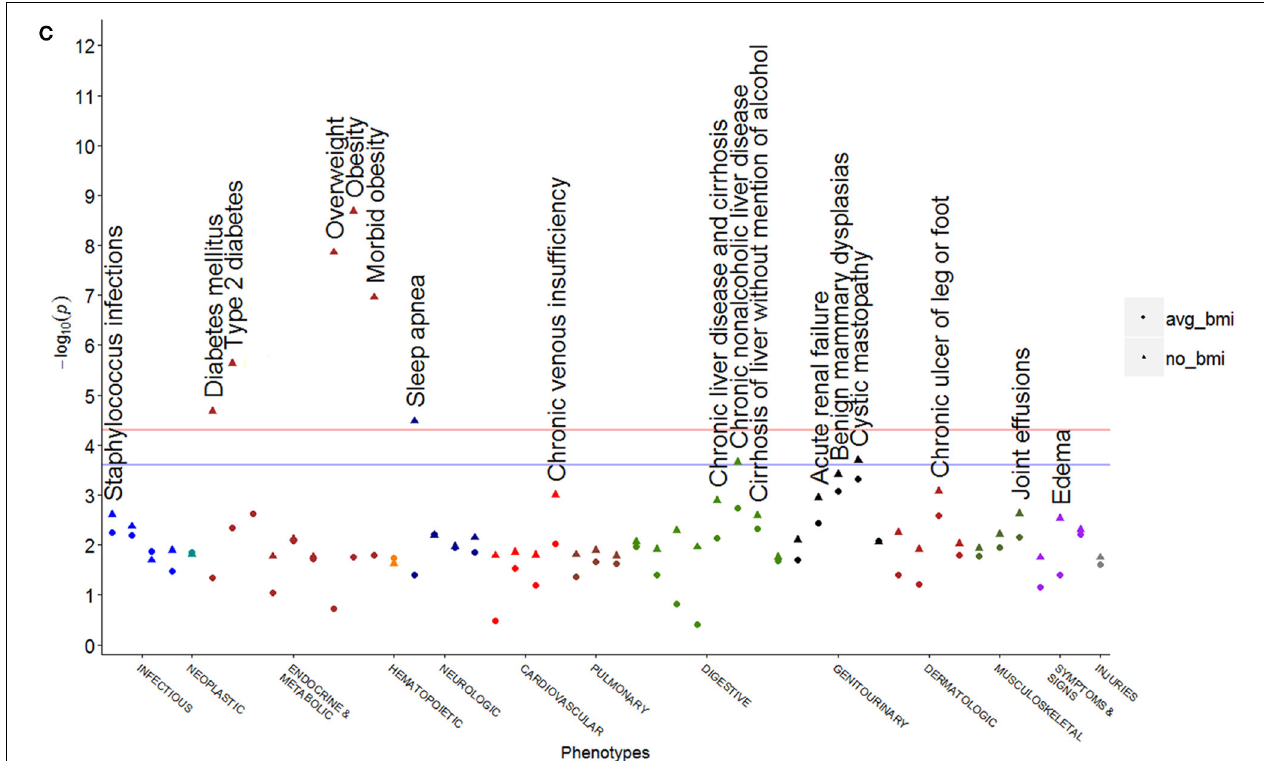
FIGURE 1 | PheWAS plots for FTO rs8050136 with and without BMI adjustment. The pink horizontal line represents p = 4 . 95 × 10 − 5 , which is the Bonferroni correction, and the blue horizontal line represents an FDR q = 0 . 05 ( p = 2 . 48 × 10 − 4 ). (A) without BMI adjustment, (B) with BMI adjustment, and